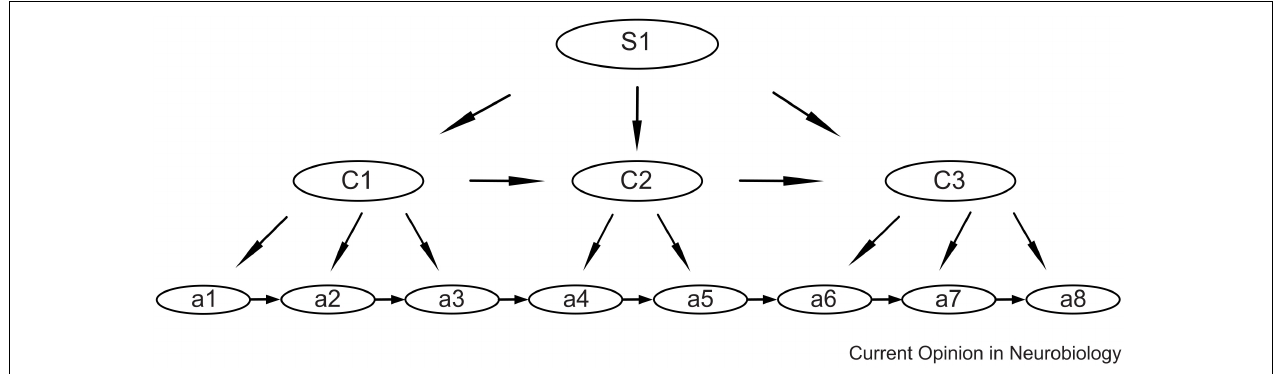
FIGURE 2 | Schematic showing the hierarchical organization model of action sequences, with sub-sequences as sub-chunks. For speech the lowest levels (a) may be the movements of individual speech muscles, the next level (C) may be phonemes, and the higher level (S) may be syllables. Syllables may, in turn, be chunked into automatized multisyllable words. Reprinted from Jin and Costa (2015) with permission.